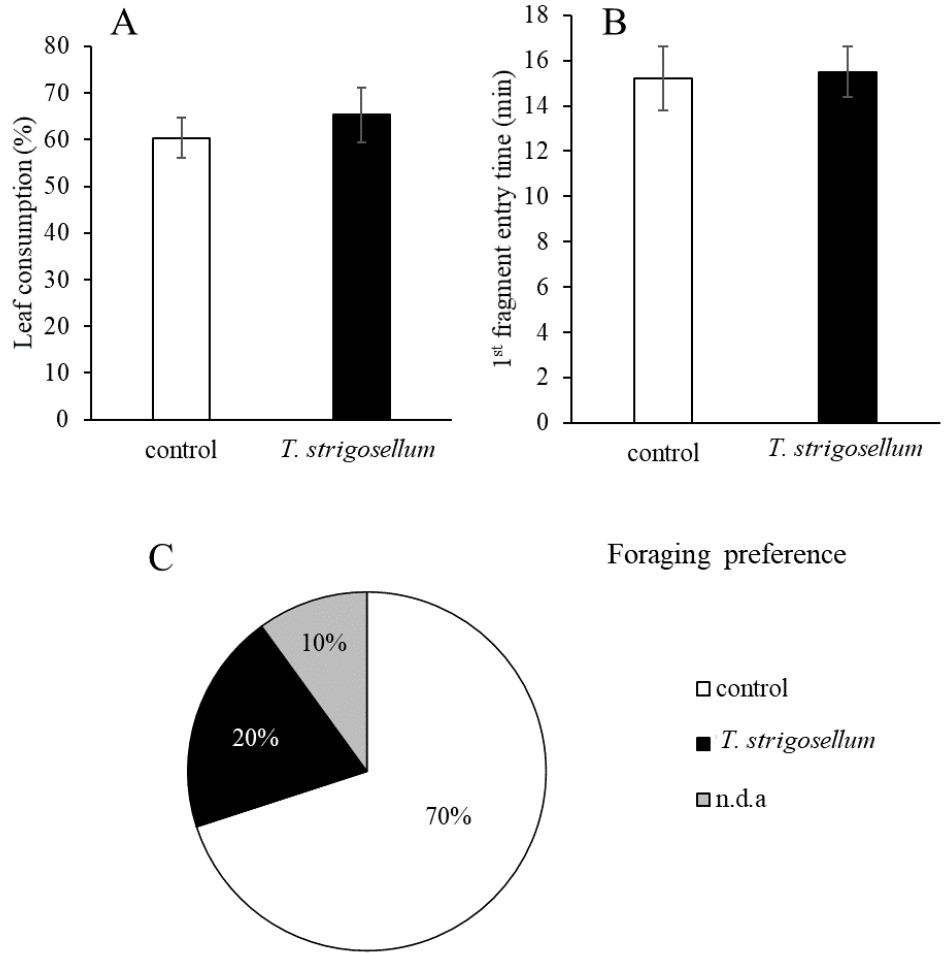
Figure 5. Changes in cutting preference of Atta sexdens for Eucalyptus urophylla inoculated with Trichoderma strigosellum . ( A ) Leaf consumption (%), ( B ) Time to entry in the first fragment of leaves (min), each column corresponds to the mean of 10 leaves ± standard errors (SE); ( C ) Foraging preference (%), indicating that in many colonies (70%) workers began cutting the leaves of the control group; proportions were significantly different ( p < 0.05).